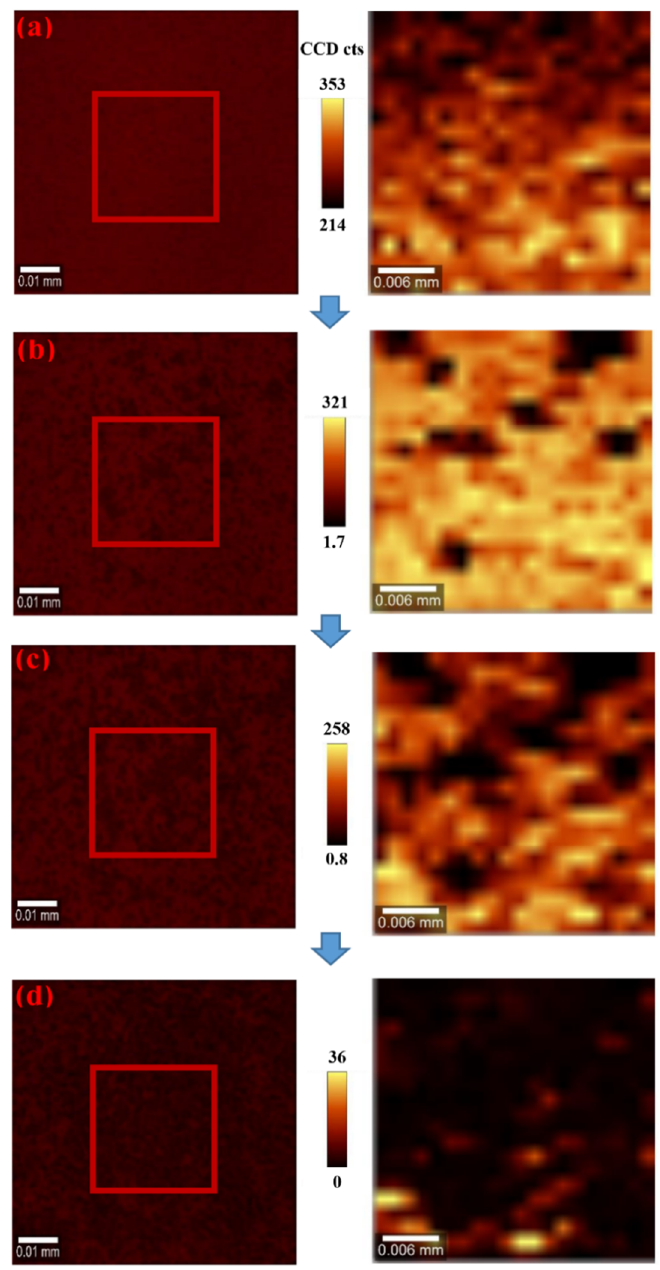
Figure 4. Optical images and the corresponding photoluminescence intensity mapping of PEA 2 MA 2 Pb 3 I 10 under continuous white light illumination at 1000 mW/cm 2 in an ambient environment with various times: ( a ) 0 min, ( b ) 20 min, ( c ) 40 min and ( d ) 100 min. For the PL intensity mapping, a 30 µm × 30 µm area was collected. The optical excitation source was a 635-nm continuous wave (CW) laser, and the excitation intensity was approximately 50 mW/cm 2 .